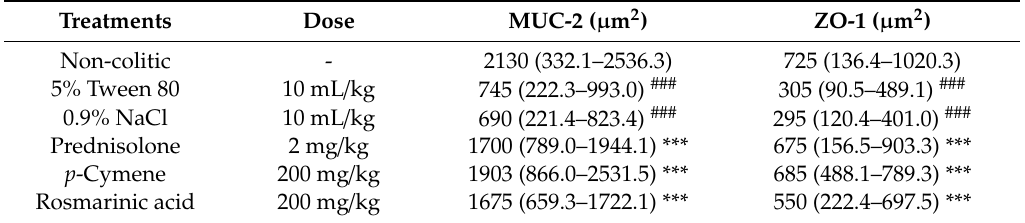
Table 2. E ff ect of oral administration of p -C and RA on MUC-2 and ZO-1 immunostaining in colonic tissue from TNBS-induced ulcerative colitis rat model.